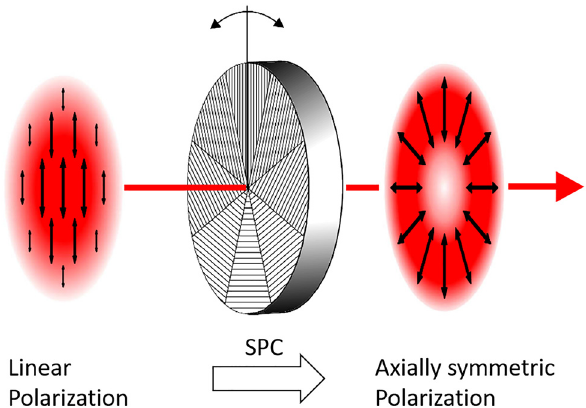
Figure 13: Principle of the conversion of a linearly polarized beam into on with axially symmetric polarization (example with 8 segments of half-wave plates). SPC: segmented polarization converter.